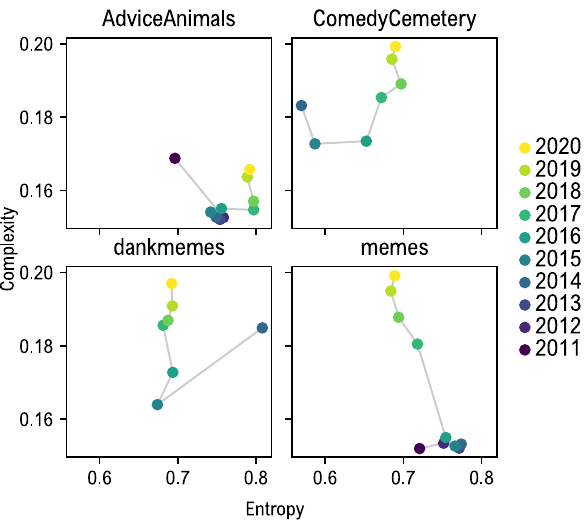
Figure 3. Trajectories in entropy-complexity plane for the four Reddit communities. All, except r/ AdviceAnimals present an evolution towards higher values of complexity that resembles that of painting arts 32 . Each dot is the average value of entropy and complexity for each year. Visually complex templates could be linked to the tendency of using memes to continuously represent social trends and attitudes, supporting the hypothesis that memes are part of the emerging internet meta-language.